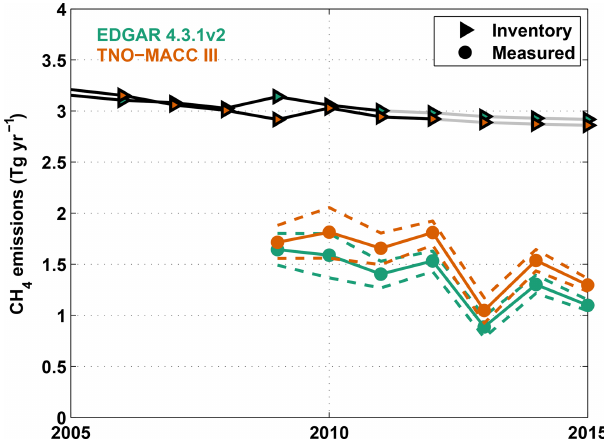
Figure 6. The black line is the summed EDGAR (green) and TNO- MACC_III (orange) methane emissions within the study area shown in Fig. 1. The grey lines indicate the projected emissions based on scaling the country-level emissions reported by the UNFCCC (UN- FCCC, 2017) to the area emissions in 2010 for EDGAR and 2011 for TNO-MACC_III. The lower solid lines show the emissions in- ferred from the TCCON anomaly analysis using CO emissions from the two models, and the dashed lines indicate the 5th and 95th per-